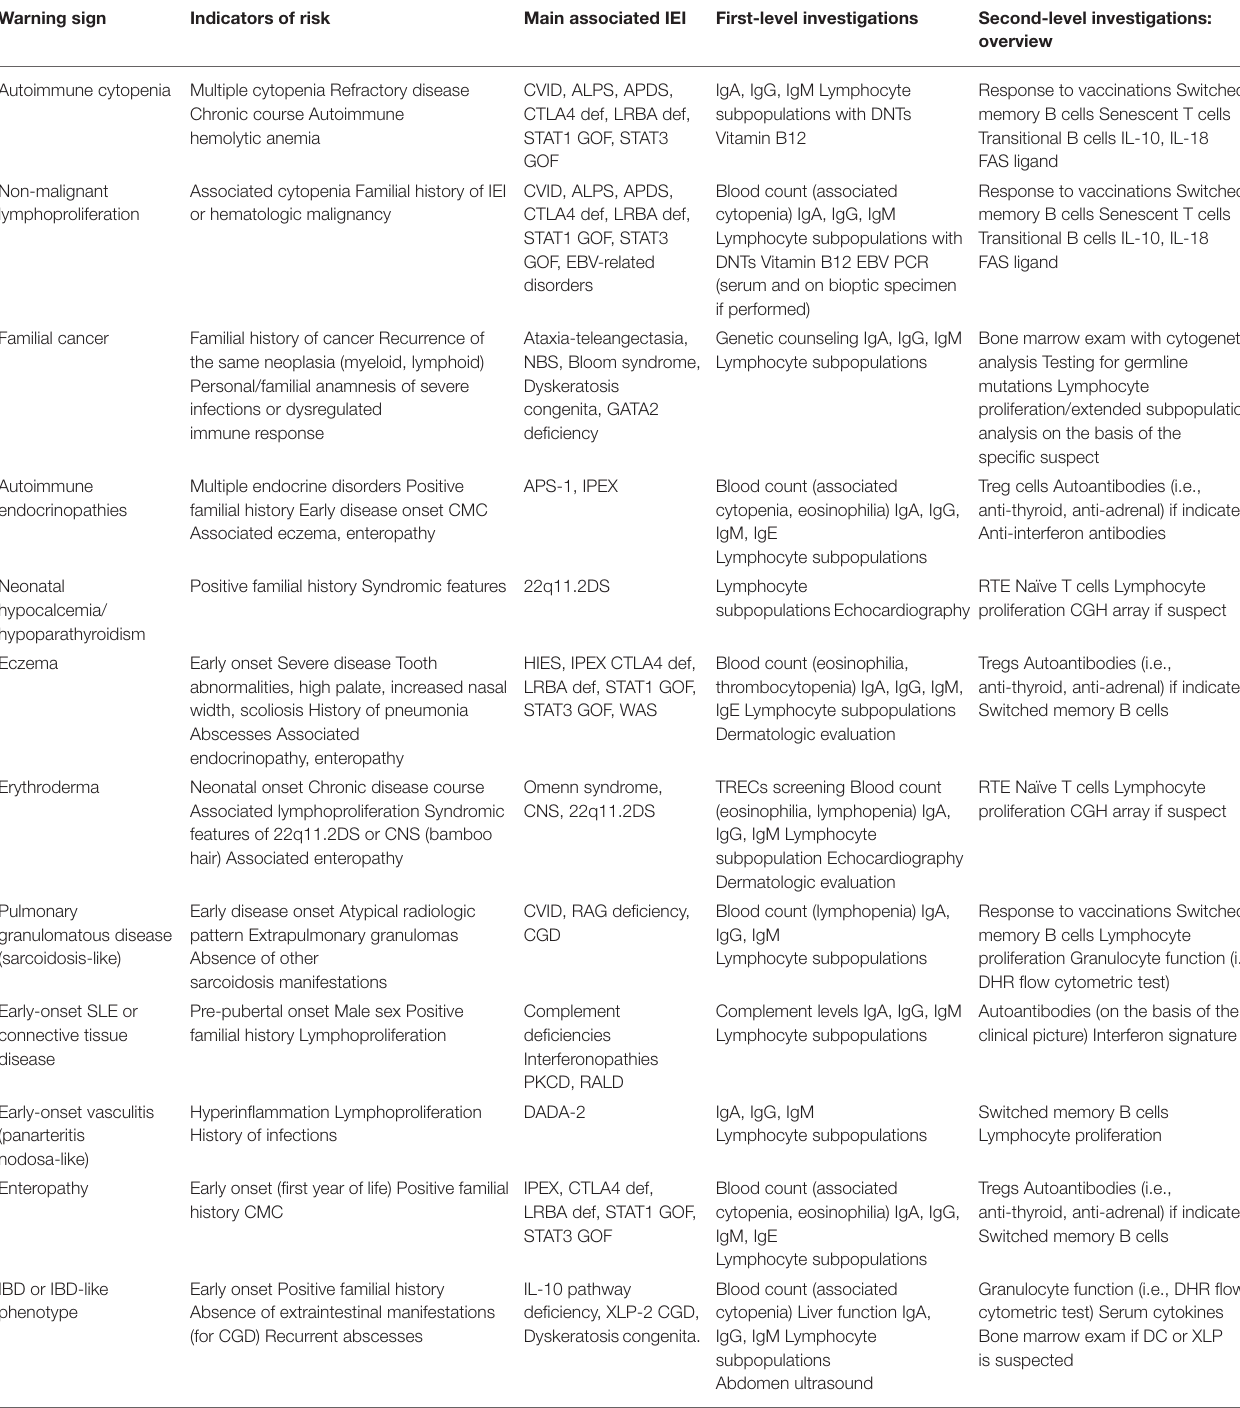
TABLE 1 | Non-infectious warning signs for inborn errors of immunity: clinical implications. Warning